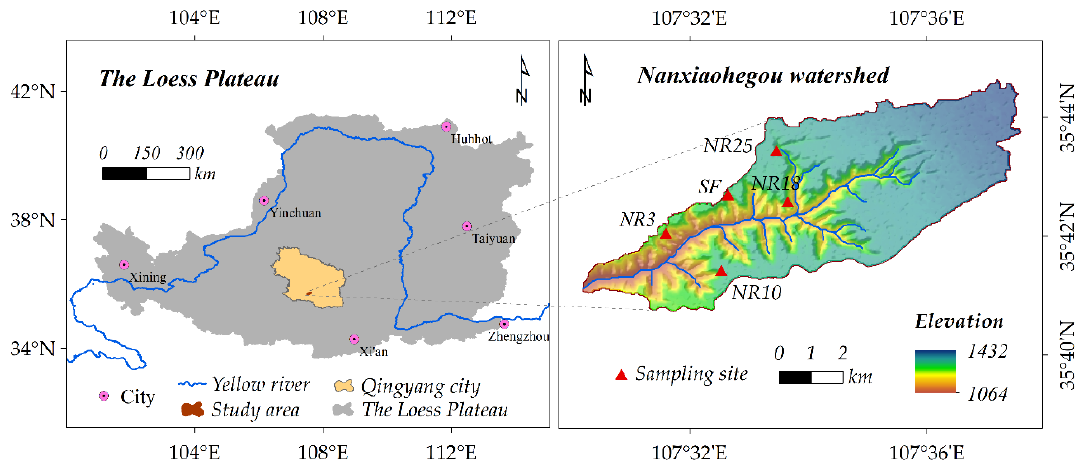
Figure 1. Location of the study area on the Loess Plateau and the location of sampling sites in the Nanxiaohegou watershed.